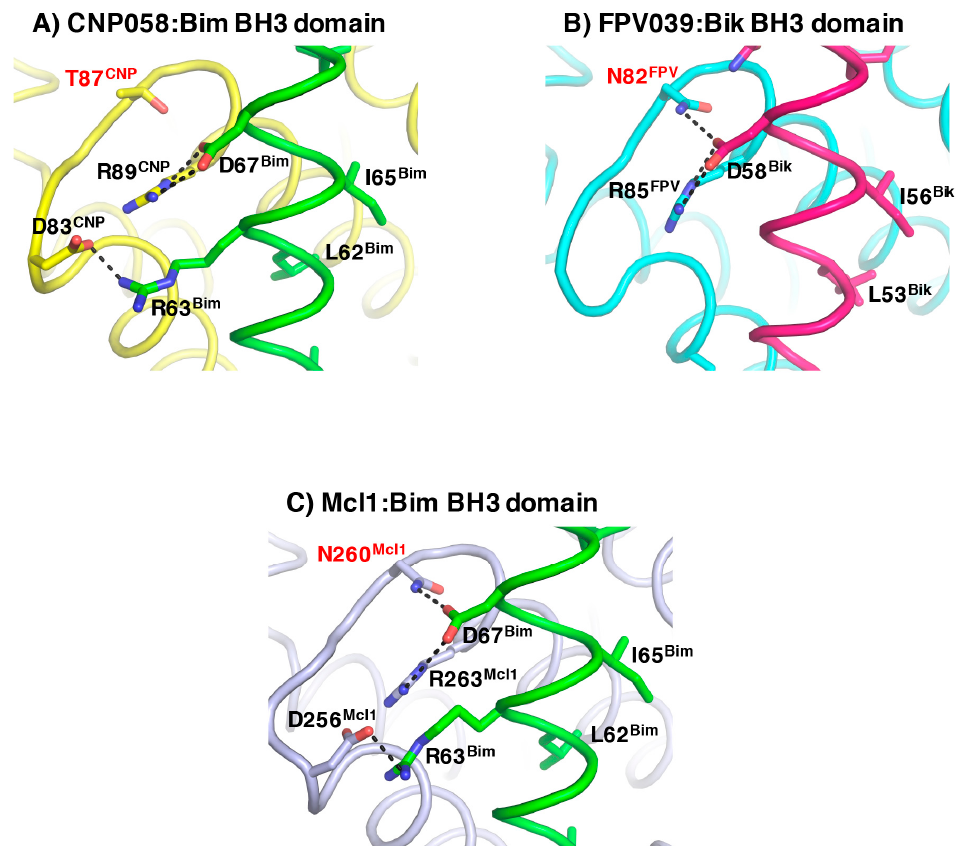
Figure 8. The role of the conserve NWGR motif. Detailed cartoon representation of the NWGR or equivalent motif in ( A ) CNP058:Bim BH3 domain complex, ( B ) FPV039:Bik BH3 domain complex and ( C ) Mcl-1:Bim BH3 domain complex. The view is into the conserved hydrophobic ligand binding groove formed by α -helices 2–5. Residues involved in interactions are shown as sticks and labelled. Hydrogen bonds and ionic interactions between pro-survival proteins and pro-apoptotic ligands are denoted as black dotted lines. The Asn residues in the NWGR motif in FPV039 and Mcl-1 as well as the Thr in the TWGR motif are labelled in red. PDB ID: FPV039:Bik = 5TZP, Mcl-1:Bim = 2NL9.